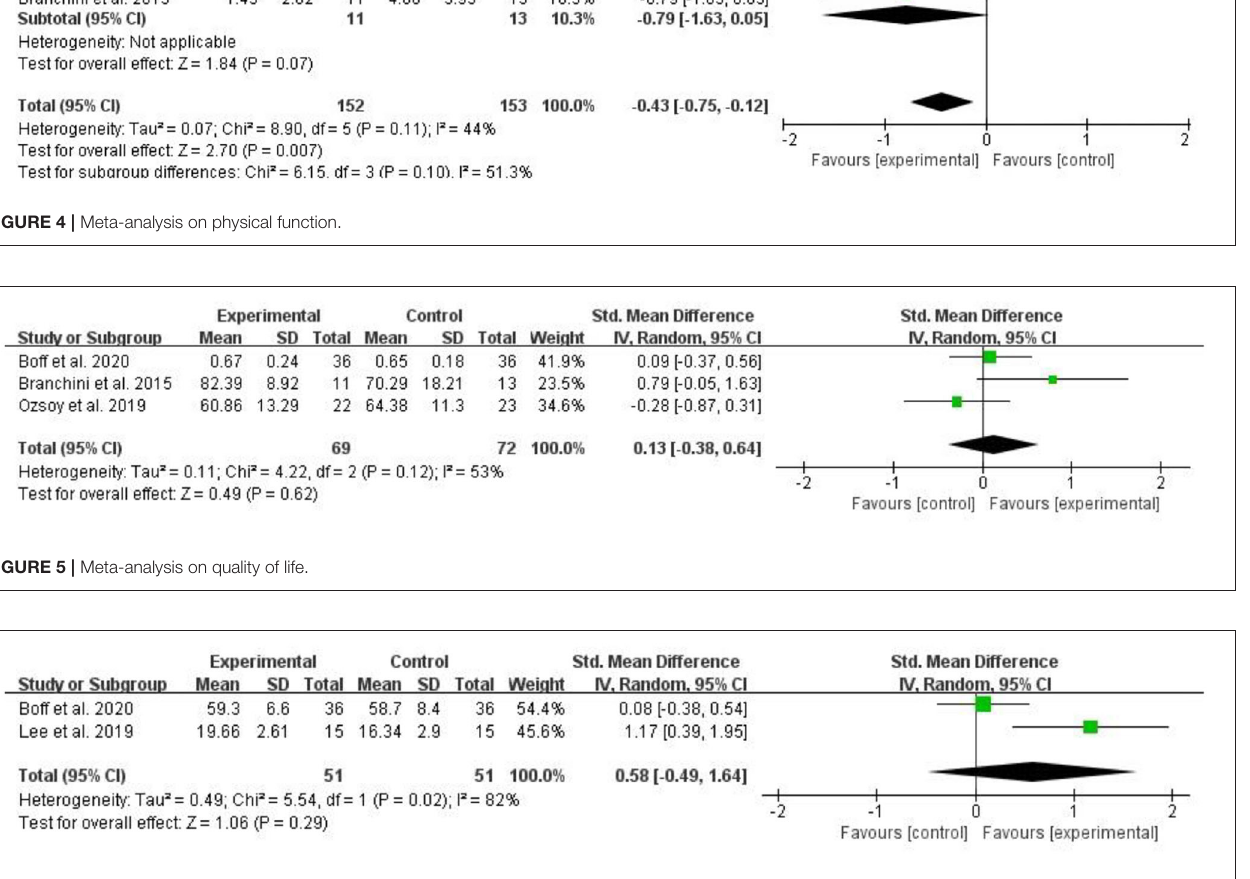
FIGURE 6 | Meta-analysis on balance function.